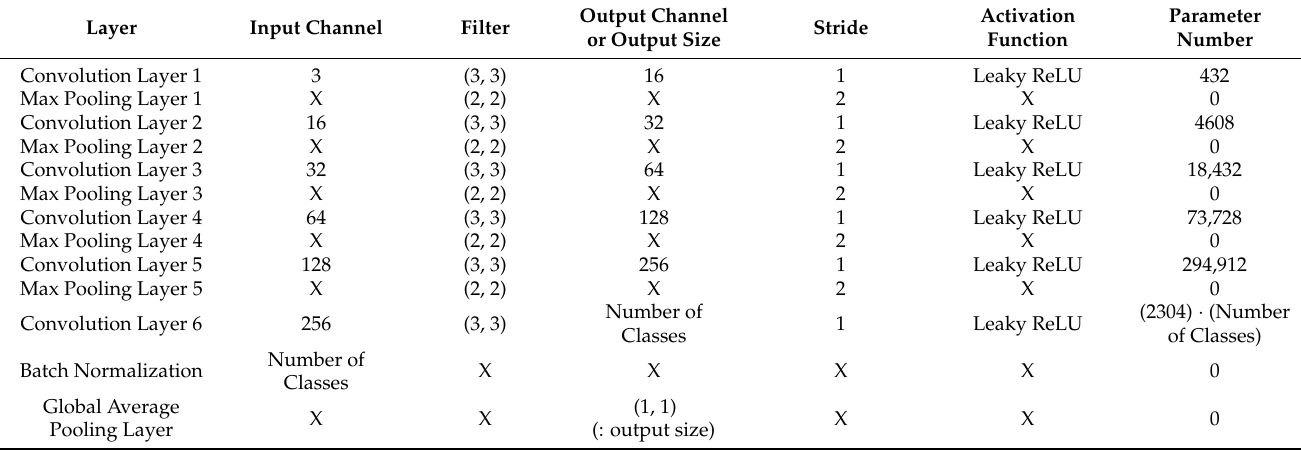
Table 1. CNN parameter (Number of Classes: 9 or